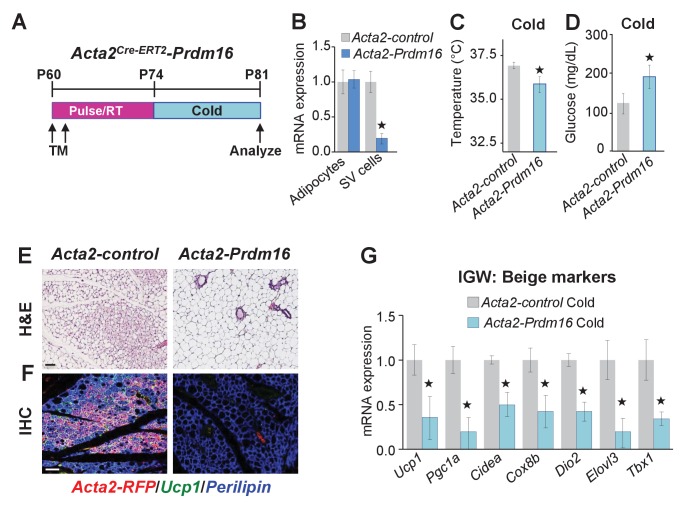
Acta2+ smooth muscle cells are required for cold induced beiging.(A) Illustration of experimental procedure for TM-induced two-month-old Acta2Cre-ERT2; RosaR26RFP (Acta2-control) male mice and Acta2Cre-ERT2; Prdm16; RosaR26RFP (Acta2-Prdm16) mice. (B) mRNA expression of Prdm16 from isolated adipocytes and SV cells from mice described in (A) after TM pulse (prior to cold exposure). (C) Rectal temperatures from Acta2-control and Acta2-Prdm16 mutant mice after cold treatment. (D) Sera glucose from Acta2-control and Acta2-Prdm16 mutant mice after cold treatment. (E) H&E staining from mice described in (G). (F) Fate mapping of Acta2-RFP: Immunostaining of Acta2-RFP (red), Ucp1 (green), and Perilipin (blue) from mice described in (G). (G) mRNA expression of beige and thermogenic genes from mice described in (G). ★p<0.001 cold exposed mutant compared to cold exposed control mice. All data are means ± SEM. Scale bar = 100 µm.